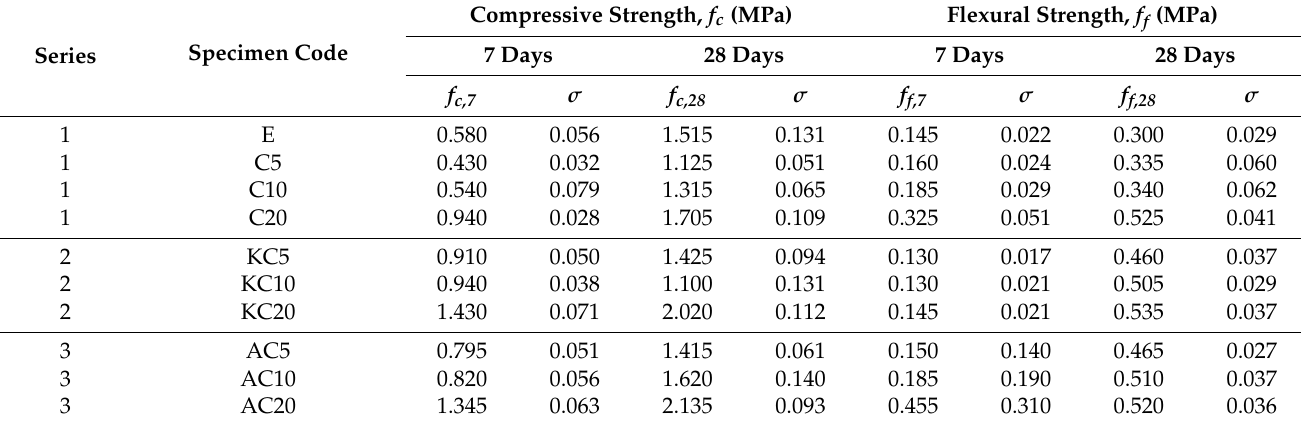
Table 2. Average compressive ( f c ) and flexural strength ( f f ), at 7 and 28 days, with their corresponding standard deviation ( σ ).